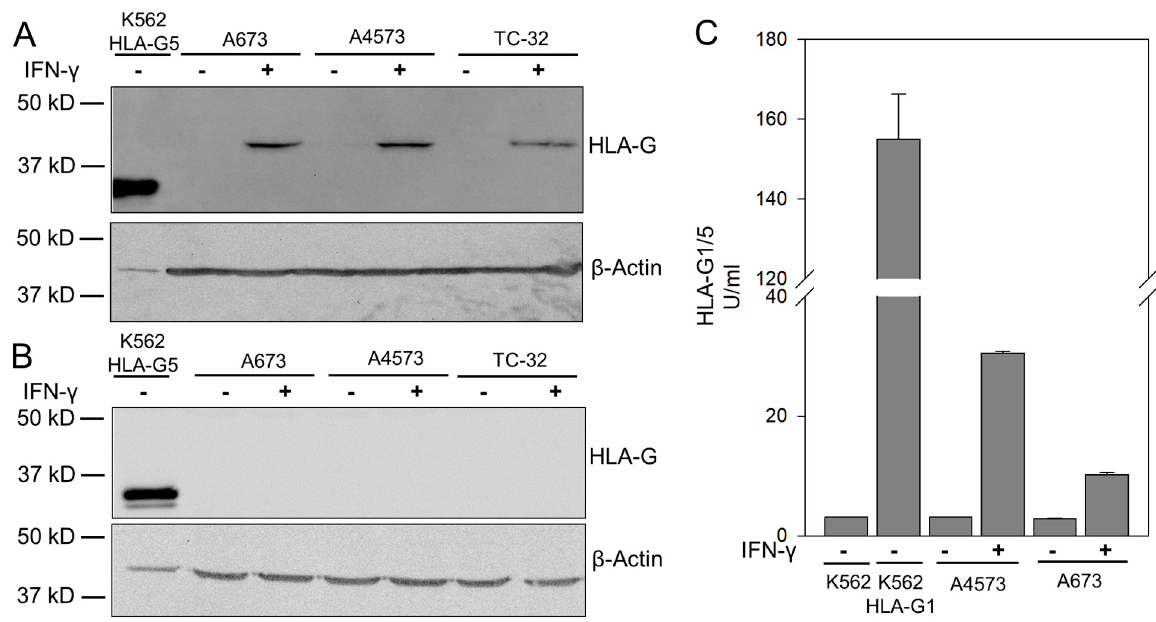
Figure 1. IFN- γ stimulated EwS cells express HLA-G isoform G1. ( A, B ) Western Blot analysis of HLA-G expression in whole cell lysates of HLA-G5-transduced K562 cells (positive control; a, 1 µg; b, 5 µg) and EwS cell lines A673, A4573 and TC-32, following pretreatment with IFN- γ or untreated (all 50 µg). ( A ) Anti-HLA-G antibody clone 4H84 (recognizing all isoforms) and ( B ) Anti-HLA-G antibody clone 5A6G7 (recognizing only isoforms HLA-G5 and G6). ( C ) Expression of HLA-G in whole cell lysates (25 µg) of wild-type K562 (negative control), HLA-G1 transduced K562 cells (positive control), and EwS cell lines A4573 and A673, following pretreatment with IFN- γ or untreated, using an ELISA exclusively detecting the isoforms HLA-G1 and G5.